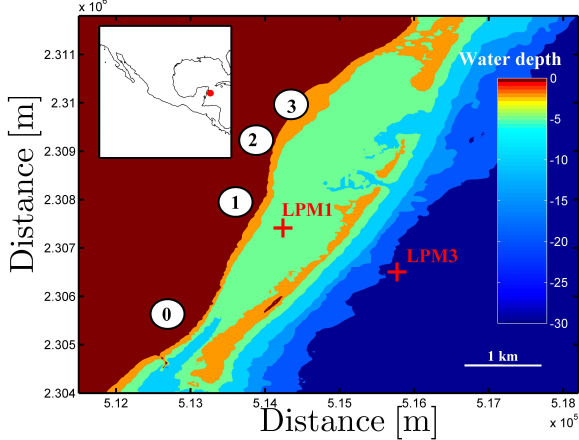
Fig. 1. Location of the study area and reef-lagoon bathymetry. The numbered circles represent the locations of the cross-reef profiles extracted for the simulations. The crosses represent wave measure- ment locations by Coronado et al.